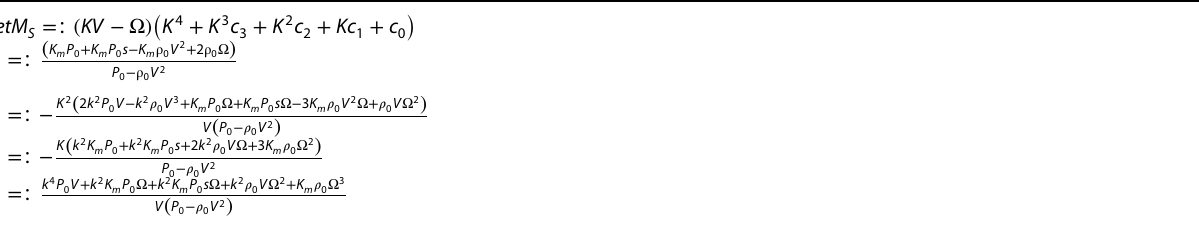
Table 2 The polynomial equation detM S = 0 and its coefficients detM KV − Ω) K 4 + K 3 c K 2 c Kc c 3 + 2 + 1 + S =∶ ( (